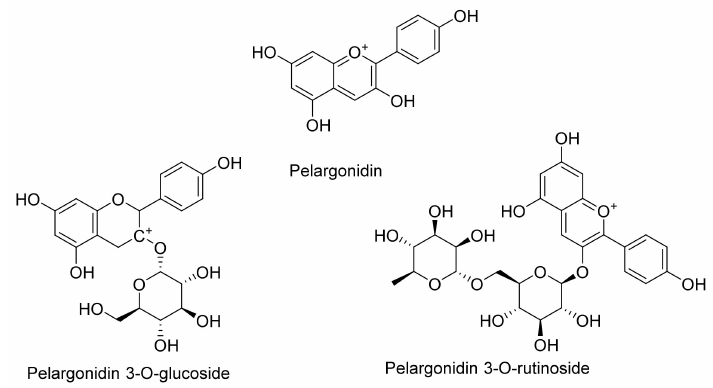
Figure 9. Chemical structure of major compounds presented in strawberry. A polyphenol-rich extract plus anthocyanin or tannin-rich sub-fractions derived from a strawberry sample at 1.5 to 50 µ g/mL were experimented against P21 (human prostate epithelial cell line), LNCaP and PC3 (tumor cell line). The strawberry extract (5 µ